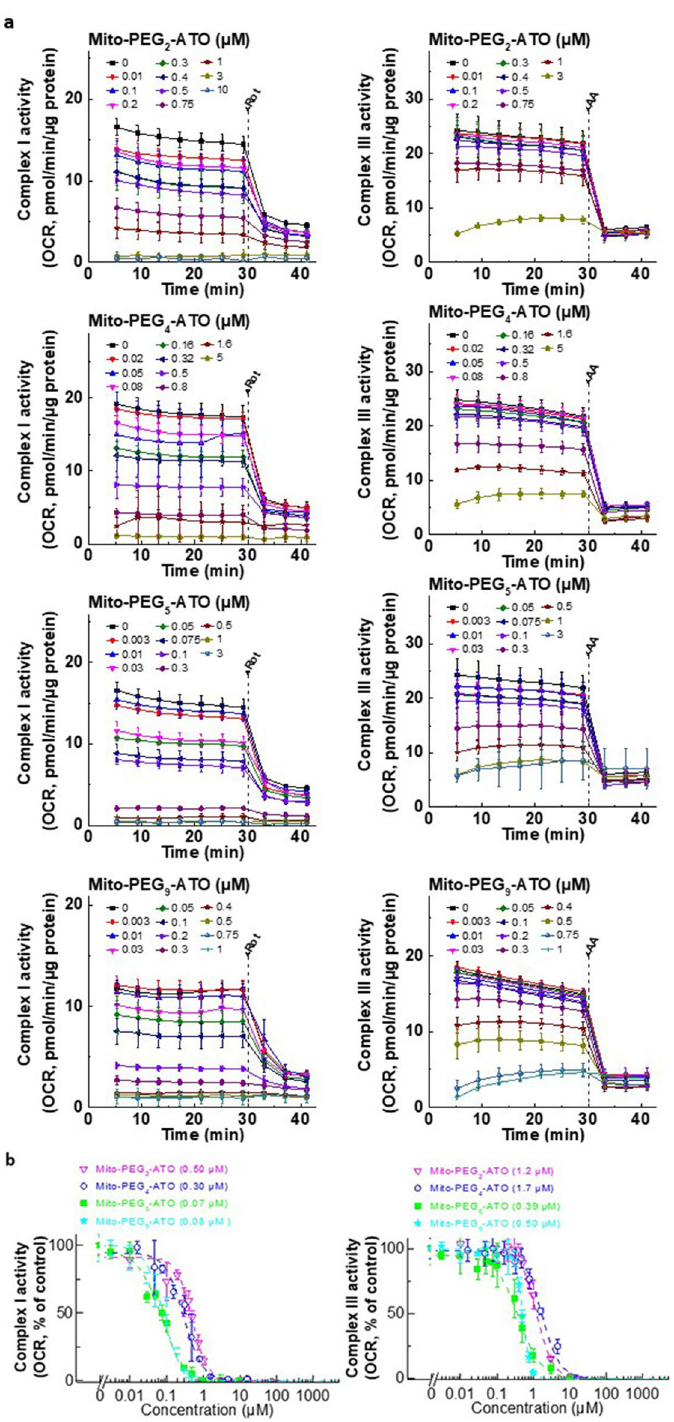
Figure 4. Effects of Mito-PEG-ATO analogs on the oxygen consumption by mitochondrial complexes I and III. ( a ) Dose-dependent effects of Mito-PEG-ATO analogs on complex I- and complex III-dependent oxygen consumption were measured in MiaPaCa-2 cells after the cells were treated with Mito-PEG-ATO analogs as indicated for 24 h. Mitochondrial complex I activity (left) and complex III activity (right) were monitored by a Seahorse XF-96 Extracellular Flux Analyzer. Either rotenone (complex I inhibitor) or antimycin A (complex III inhibitor) was acutely added and OCR assayed immediately. ( b ) The mitochondrial complex I (left) and III (right) dependent oxygen consumption (calculated as rotenone or antimycin A inhibitable OCR) are plotted against concentration of Mito-PEG-ATO analogs. Dashed lines represent the fitting curves used for determination of the IC 50 values. Data shown are the mean ±